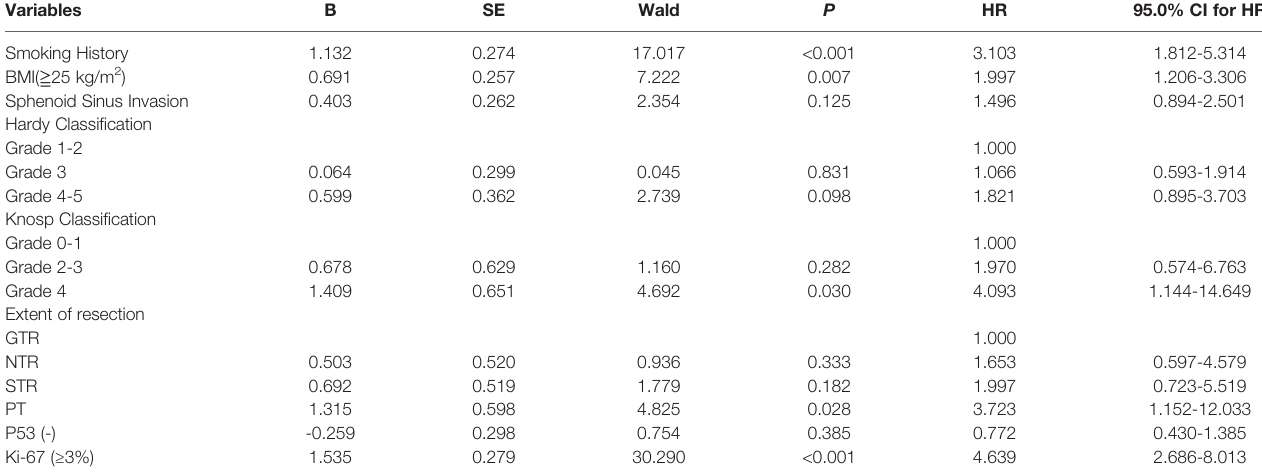
TABLE 3 | Multivariate analysis results.